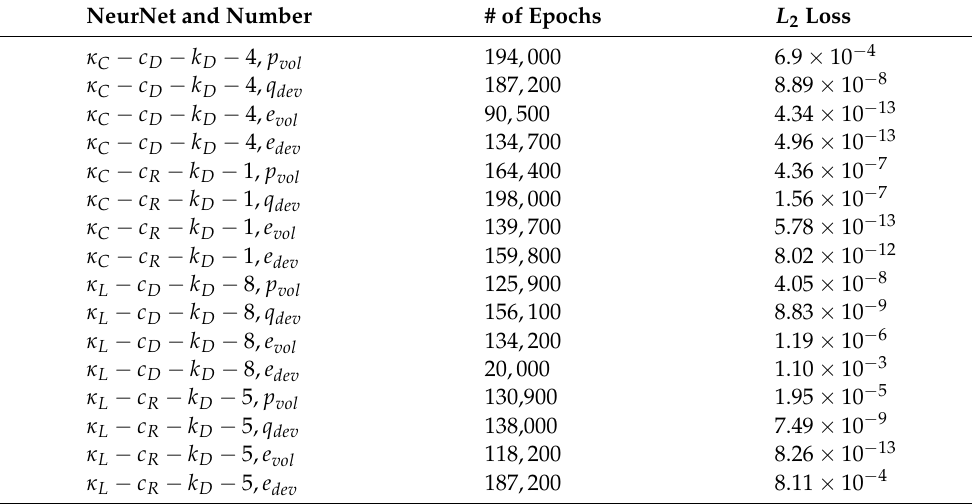
Table 3. Number of epochs for convergence and the corresponding L 2 loss for Neural Networks for Monte Carlo simulations of porous analyses with deterministic shape functions for the stochastic material variables ( κ considered constant over